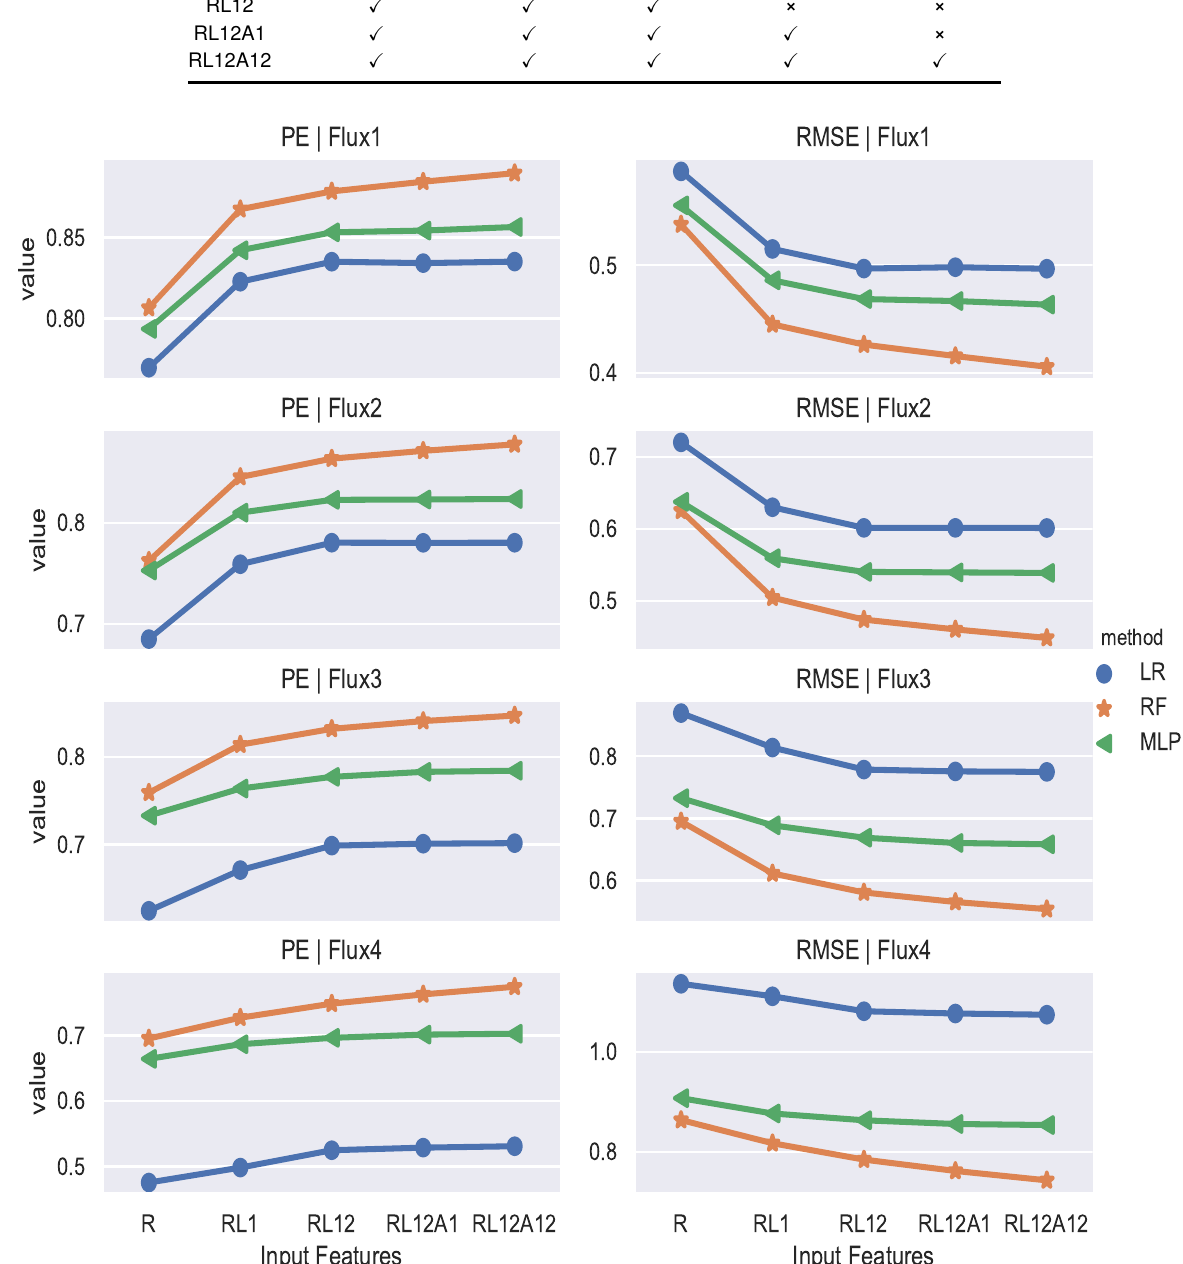
Figure 7. Predictive efficiency (PE) and root mean squared error (RMSE) of Linear Regression (LR), Random Forest (RF), and Multi- Layer Perceptron (MLP) with five different input feature combinations for the four targets (Flux1, Flux2, Flux3, and Flux4), showing the mean over 20 times repeated